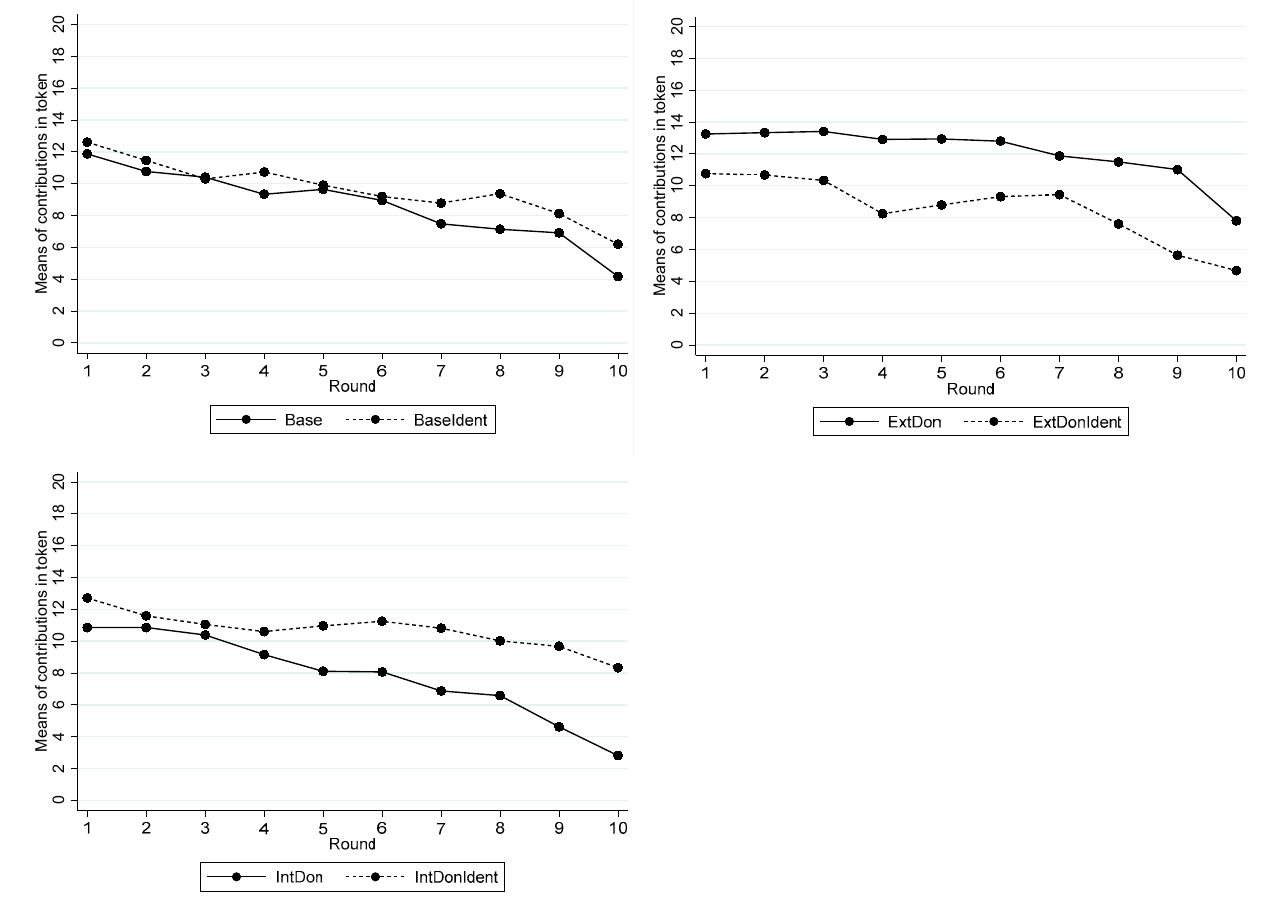
Figure 3. Means of contributions over rounds by treatment. Table 2. Means of one-shot contribution, beliefs, and contribution in tokens.